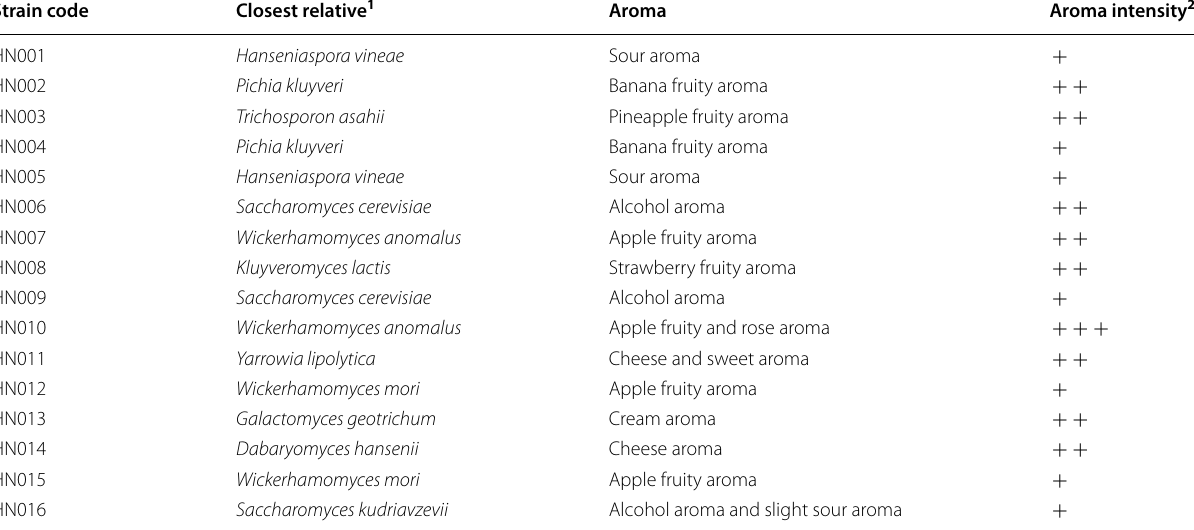
1 The Closest relative was in corresponding with that of Fig. 1 2 Weak ( ), intermediate ( +